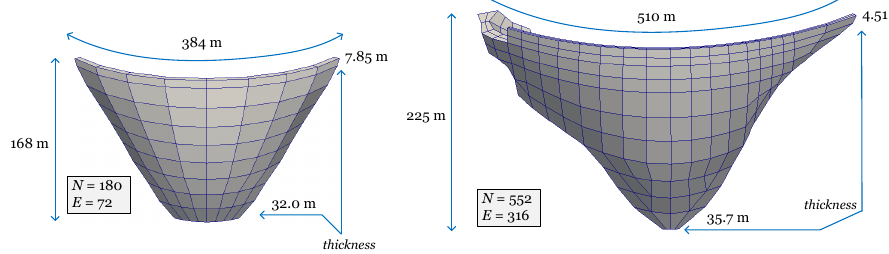
Figure 3. Finite element model of the case study dams with main dimensions (not to